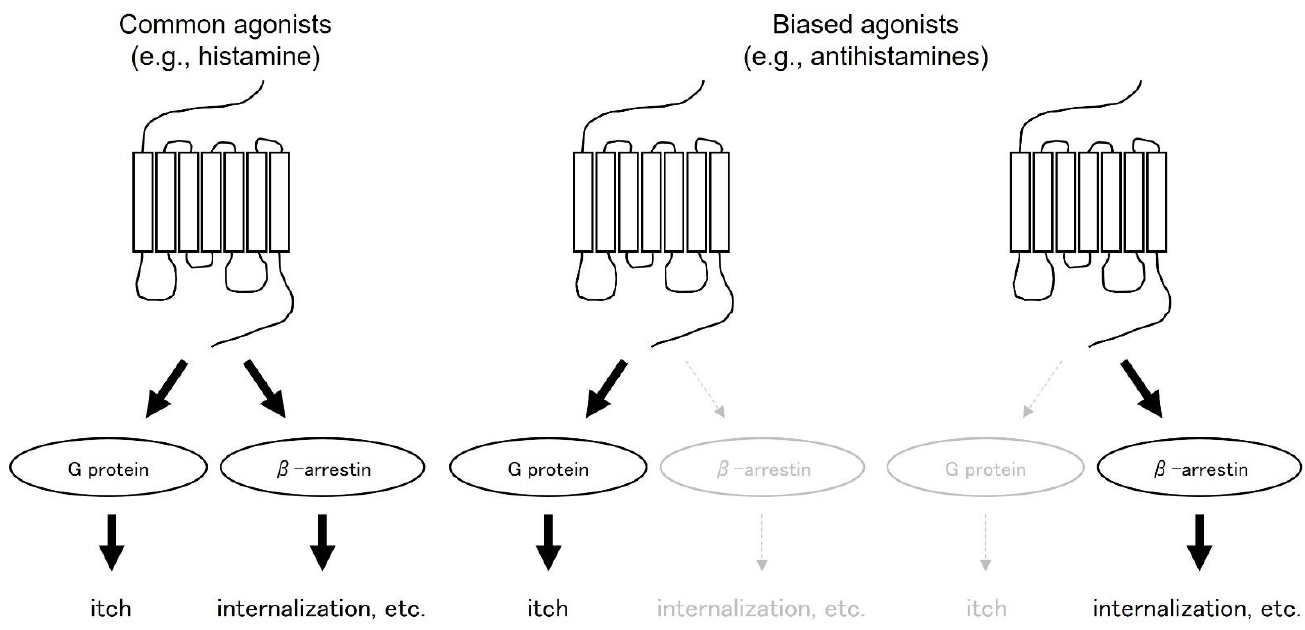
Figure 2. Biased agonist